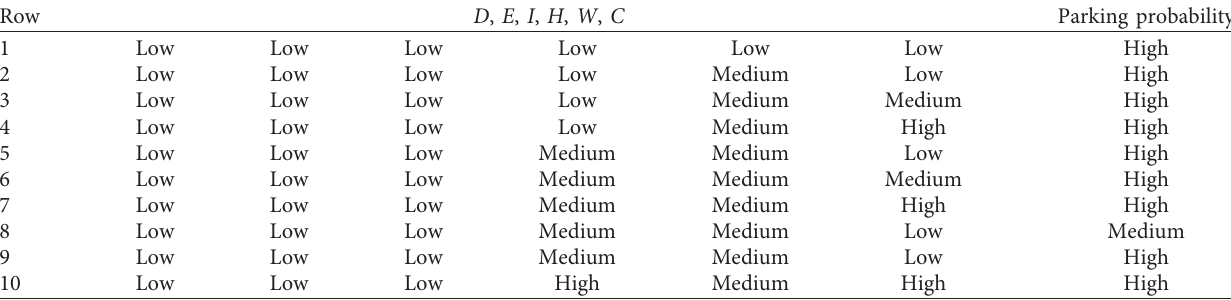
Table 1: Fuzzy rules to determine probability of parking by students.